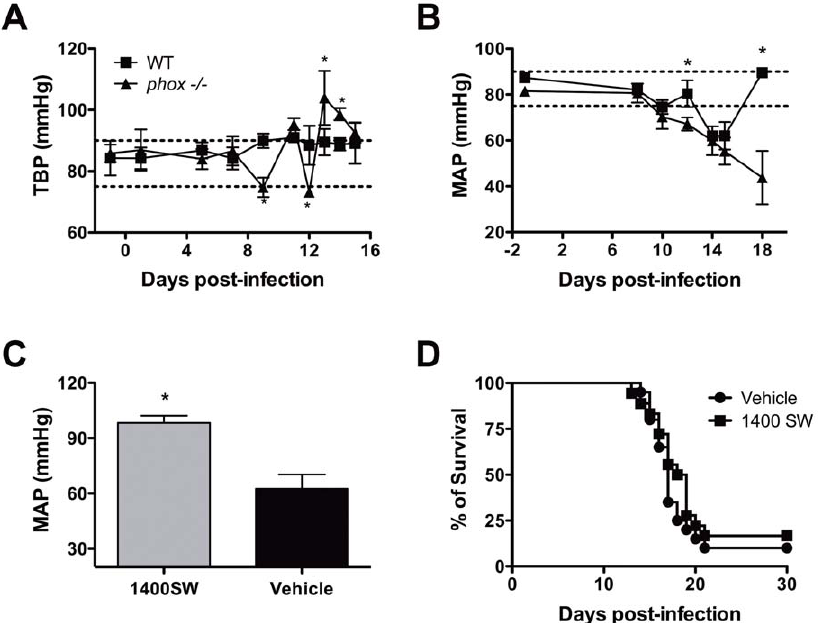
Figure 5. T.cruzi- infected phox KO mice display dramatic blood pressure variations. WT and phox KO animals were infected with T. cruzi and blood pressure evaluated in the tail (TBP) (A) or in the carotid artery (MAP) (B). Values represent mean 6 SE of 6 mice of one from two performed (A) or 2–6 mice per time point pooled from 3 independent experiments (B). Asterisks represent P , 0.05. (C) Drop in blood pressure is reverted by iNOS-specific inhibitor 1400SW. phox KO animals were infected with T. cruzi and blood pressure evaluated in the carotid artery (MAP) 16 days post- infection. Mice treated with 1400W received 15 mg/kg 24 and 1 hour before measurements. Values represent mean 6 SE of 4 mice of one from two performed. Asterisks represent P , 0.05. (D) 1400W did not revert mortality in phox KO mice. Mice were treated with 20 mg/kg of 1400W ip daily in single dose or divided in 2 doses starting on day 13 post-infection for 14 days. Mortality was accessed daily. Points represent mean cumulative mortality of 18–20 animals per group. Pool from 3 experiments performed with similar results (two experiments using one dose per day regime and one using two doses per day regime).